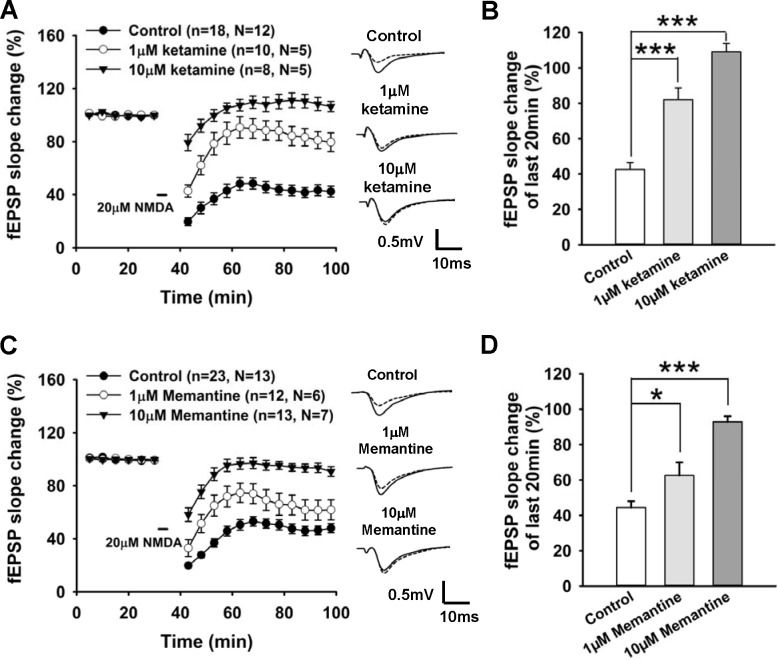
1 μM and 10 μM ketamine and memantine reduced LTD in hippocampal CA1 region.A, Effect of 1 μM and 10 μM ketamine on LTD. Baseline fEPSP was recorded for 30 min followed by 3 min perfusion of 20 μM NMDA (indicated by the horizontal bar). Field stimulation and recording was suspended during NMDA perfusion, resumed 10 min after NMDA application, and sustained for another 1 hr. Ketamine was applied before the baseline recording. Insets, representative fEPSP traces of 5 min before NMDA application (solid curve) over fEPSP traces of the last 20 min recording (dotted curve) for control group (upper), 1 μM ketamine group (middle) and 10 μM ketamine group (lower). B, Summarized data showing average slope change (normalized to baseline value) of the last 20 min recordings from each group. C, Effect of 1 μM and 10 μM memantine on LTD with the same protocol was used for ketamine. Memantine was applied before the baseline recording. Insets, representative fEPSP traces of 5 min before NMDA application over averaged fEPSP of the last 20 min recordings for control group (upper), 1 μM memantine group (middle) and 10 μM memantine group (lower). D, Summarized data showing averaged slope changes (normalized to baseline value) of the last 20 min recordings following NMDA application for control group and different memantine dose groups. All data are expressed as mean ± SEM; **p<0.01, ***p<0.001.